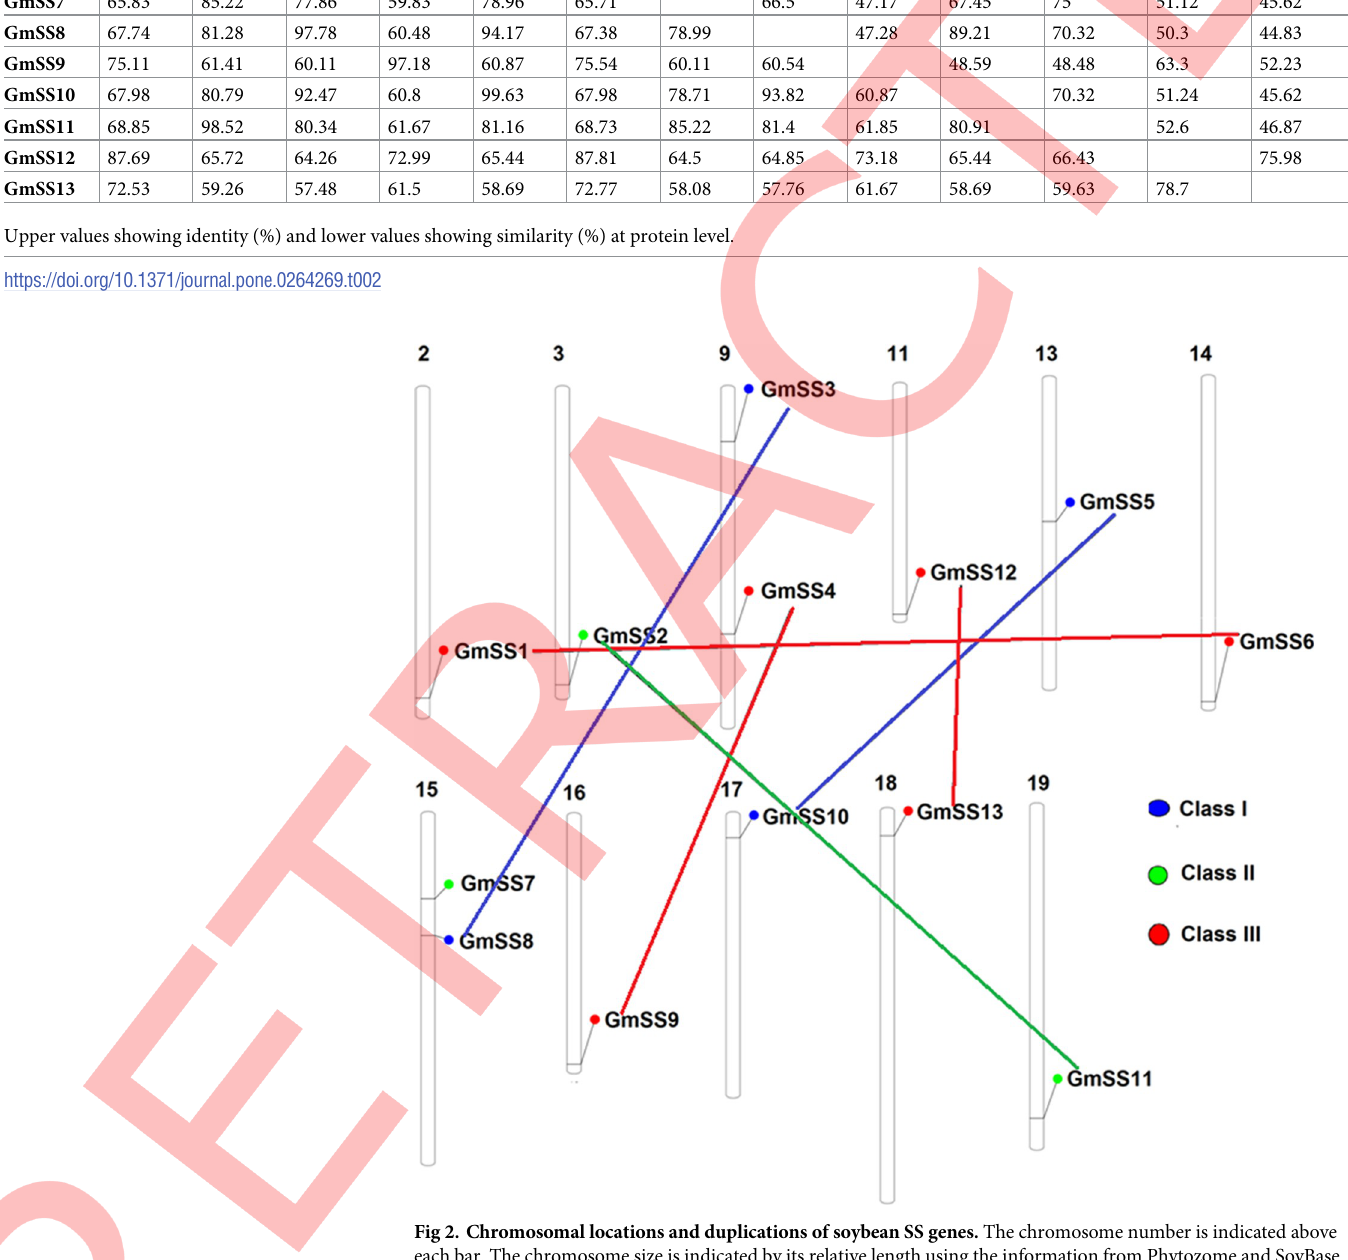
Fig 2. Chromosomal locations and duplications of soybean SS genes. The chromosome number is indicated above each bar. The chromosome size is indicated by its relative length using the information from Phytozome and SoyBase. Each pair of segmental duplication is indicated by a rline of espective class